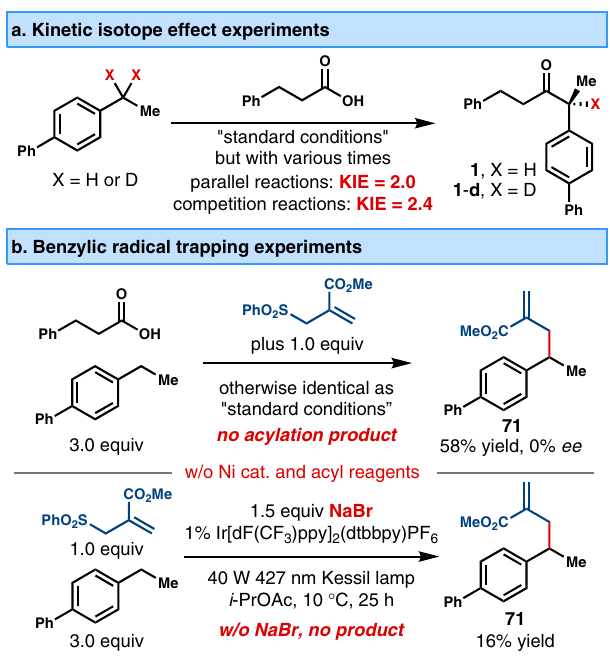
Fig. 5 Mechanistic observations. a Kinetic isotope effect experiments. b Benzylic alkyl radical trapping